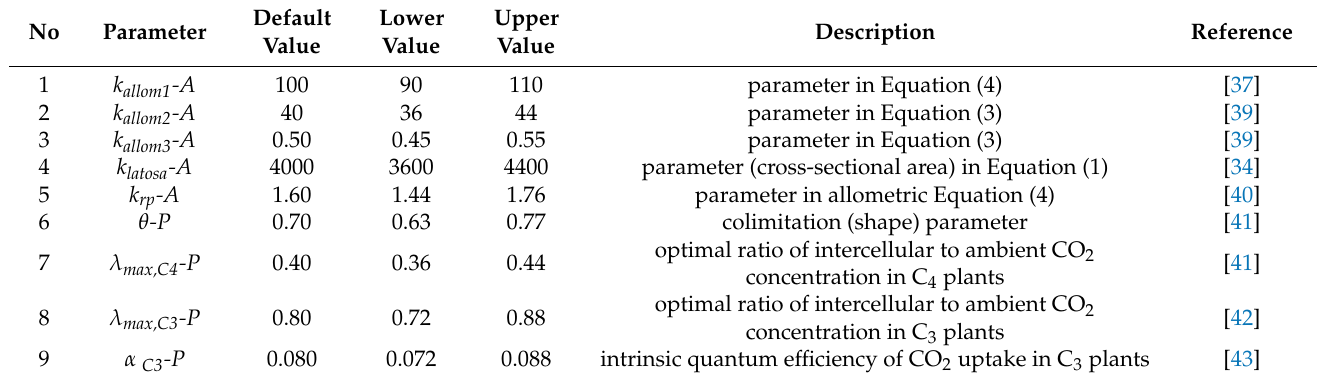
Table 1. Definition and intervals of the LPJ model parameters used for the sensitivity